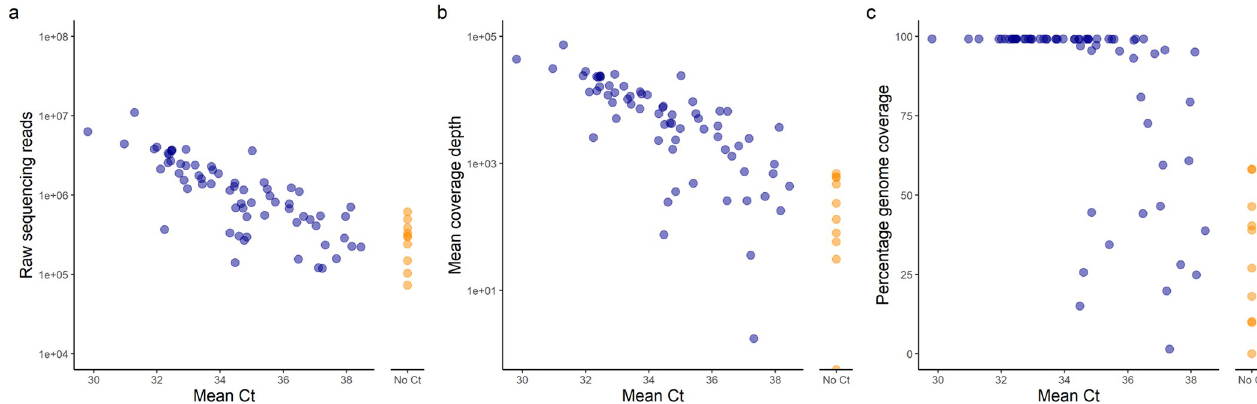
Fig 7. Sequencing results from a set of 77 wastewater samples. Scatterplots demonstrating how sequencing and alignment data, including total number of raw reads (a), mean coverage depth (b) and percentage coverage breadth (c), vary across samples with a range of Ct values from SARS-CoV-2 RT-qPCR. Colour of points represents whether a Ct value was determined (blue) or not determined